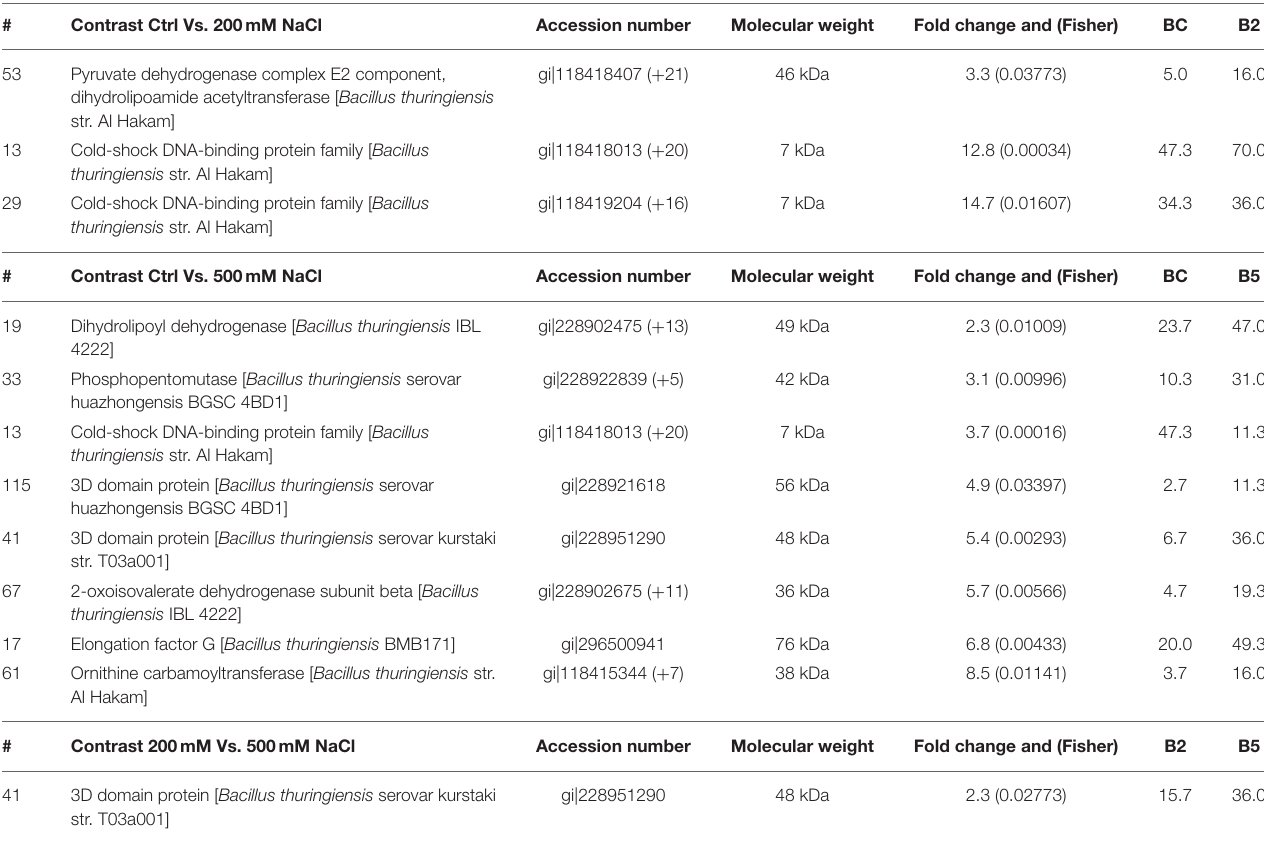
TABLE 3 | Proteins identified in both fold change and Fishers test in all the contrasts. Contrast Ctrl Vs. 200mM